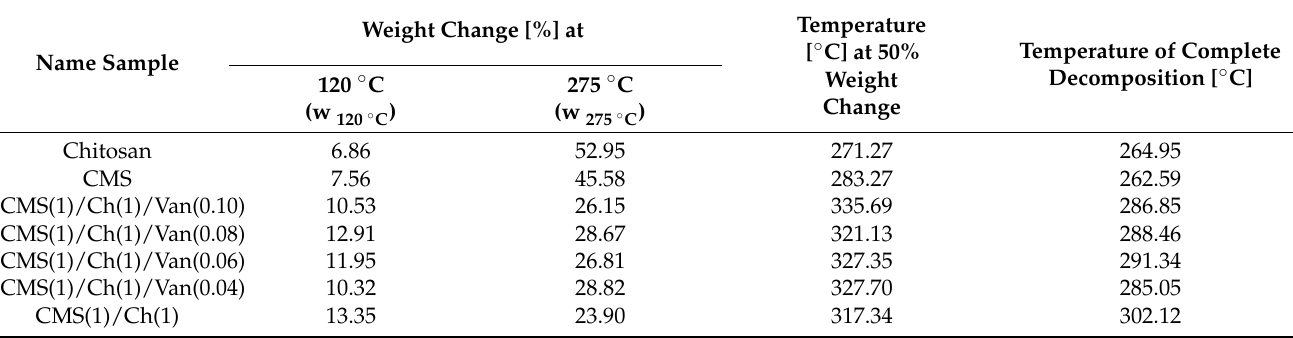
Table 3. TG data for samples composed of chitosan and carboxymethyl starch with different vanillin